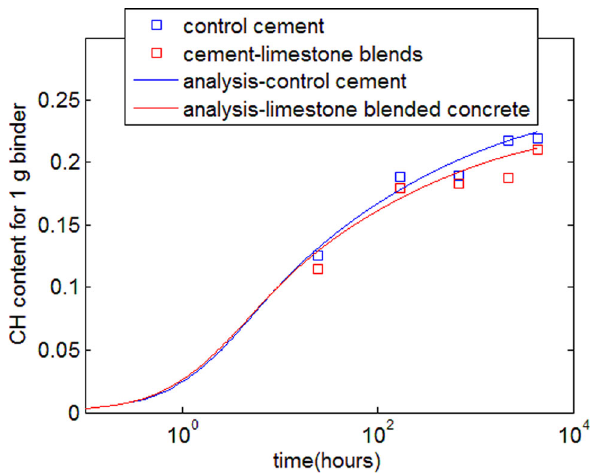
Fig. 3 CH content of cement-limestone blends (water to binder ratio 0.5, 5%